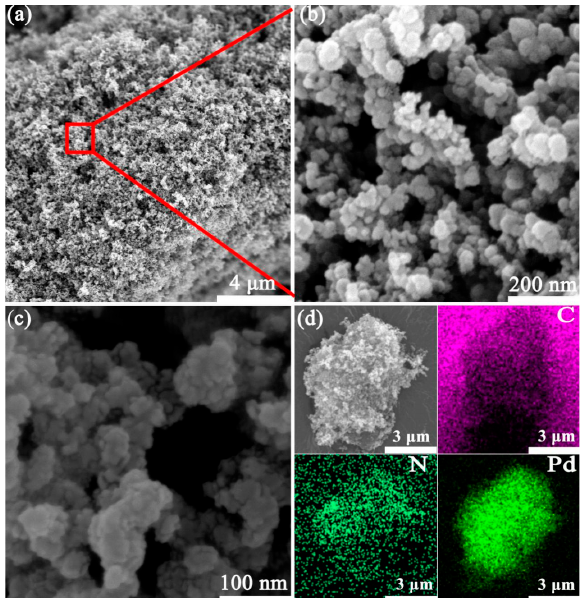
Figure 1. SEM ( a – c ) and element mapping images ( d ) of Pd/C 3 N 4 -C. Catalysts 2020 , 10 , x FOR PEER REVIEW Pd particle sizes are estimated from images (Figure 2a–c) by transmission electron microscopy (TEM). All nanoparticles (NPs) in the images are considered. The average Pd particle sizes (Figure 2d–g) of Pd/C 3 N 4 , Pd/C, and Pd/C 3 N 4 -C are 3.6, 4.6, and 3.3 nm, respectively. The introduction of C 3 N 4 dramatically decreases the diameter of palladium nanoparticles; thus, the total surface area is increased. More active sites can be provided with an increased surface. The N atoms in C 3 N 4 exhibit a strong complexing ability for Pd atoms/ions [19], which is beneficial for strong metal support